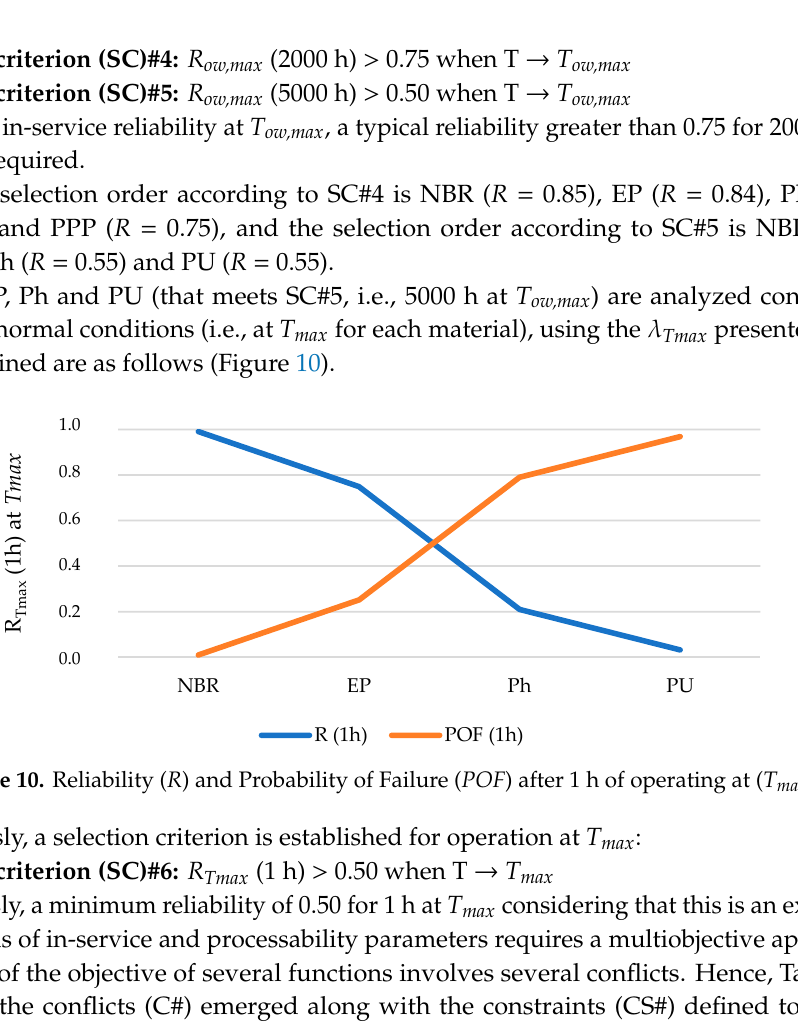
Figure 9. Reliability ( R ) and Probability of Failure ( POF ) for 1000 h ( a ), 2000 h ( b ) and 5000 h ( c ) under the maximum operating window temperature ( T ow,max ).